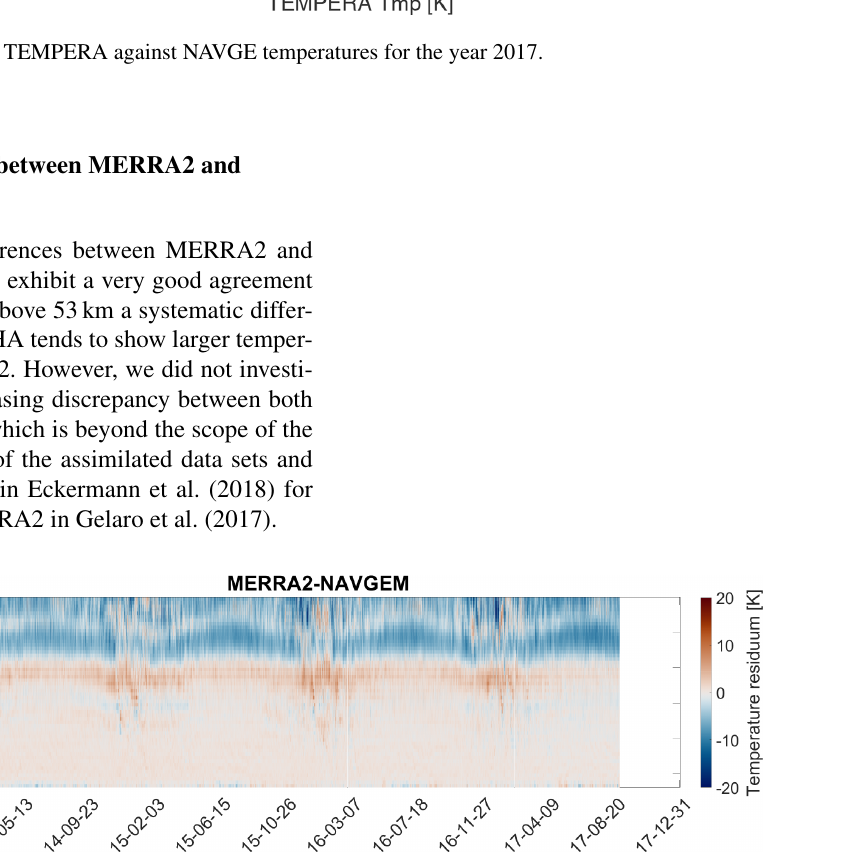
Figure B1. Absolute temperature difference between the MERRA2 and NAVGEM-HA datasets shows seasonal patterns above 45km. The color scale is the same as in Fig.